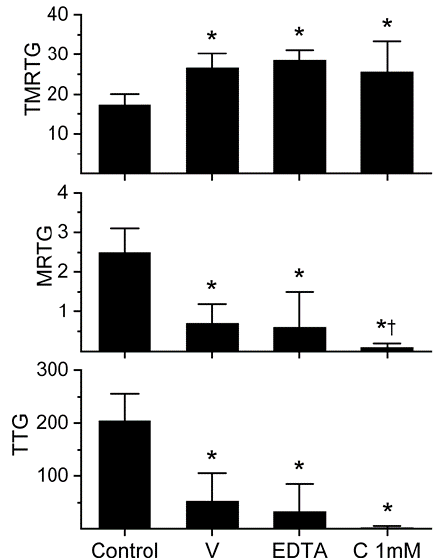
Figure 1. Anticoagulant activity of D. polylepis venom in human plasma and effects of EDTA and Figure1. Anticoagulantactivityof D.polylepis venominhumanplasmaande ff ectsofEDTAandCORM-2 CORM-2 on venom activity. Data are presented as mean ± SD. TMRTG = minutes; MRTG = on venom activity. Data are presented as mean ± SD. TMRTG = minutes; MRTG = dynes / cm 2 / sec; TTG = dynes / cm 2 . Control = no additives; V = 500 µ g / mL final venom concentration; EDTA = 500 µ g / mL venom after being exposed to 5 mM EDTA; C 1 mM = 500 µ g / mL venom after being exposed to 1 mM CORM-2. * p < 0.05 vs. control. † p < 0.05 vs.